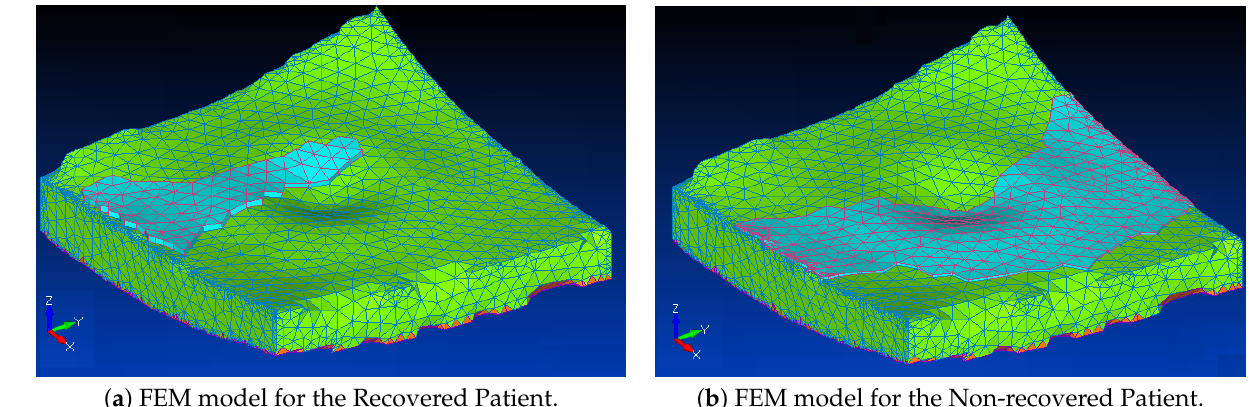
Figure 6. FEM models for Patient 1 and Patient 2.